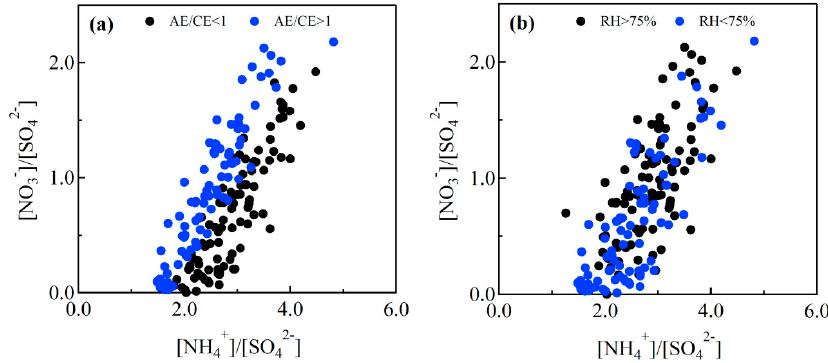
Figure 7. Relationship between [NO 3 − ]/[SO 42 − ] and [NH 4+ ]/[SO 42 − ] under different ( a ) acidity and ( b ) RH.